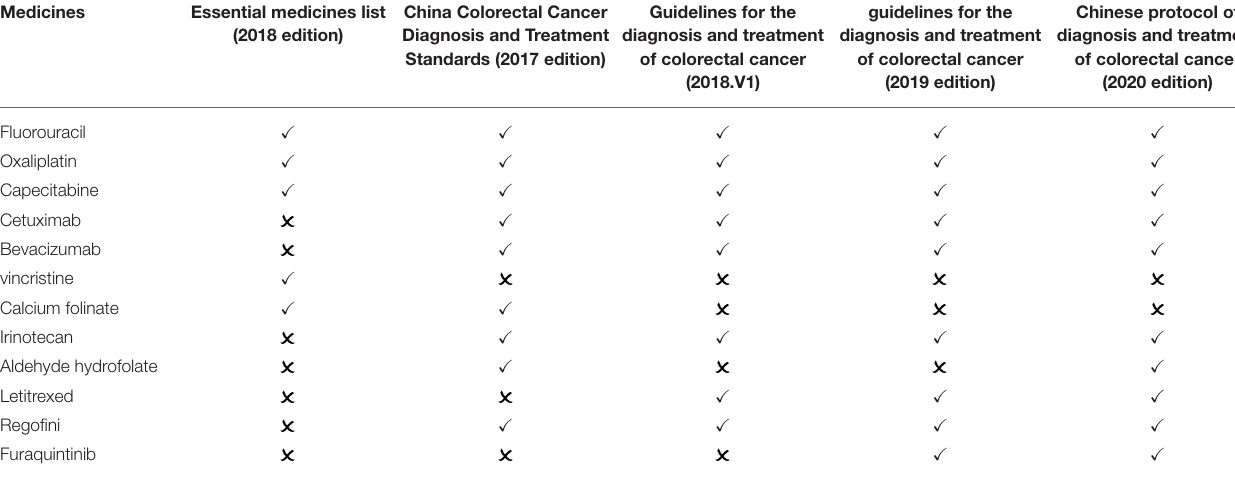
TABLE 5 | Medicines in the list and guidelines for the treatment of colorectal